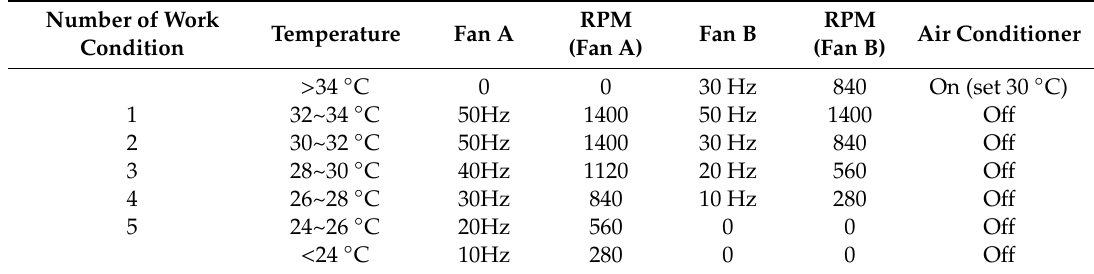
Table 2. The experimental plan of fan frequency based on five working conditions. RPM = revolutions per minute.